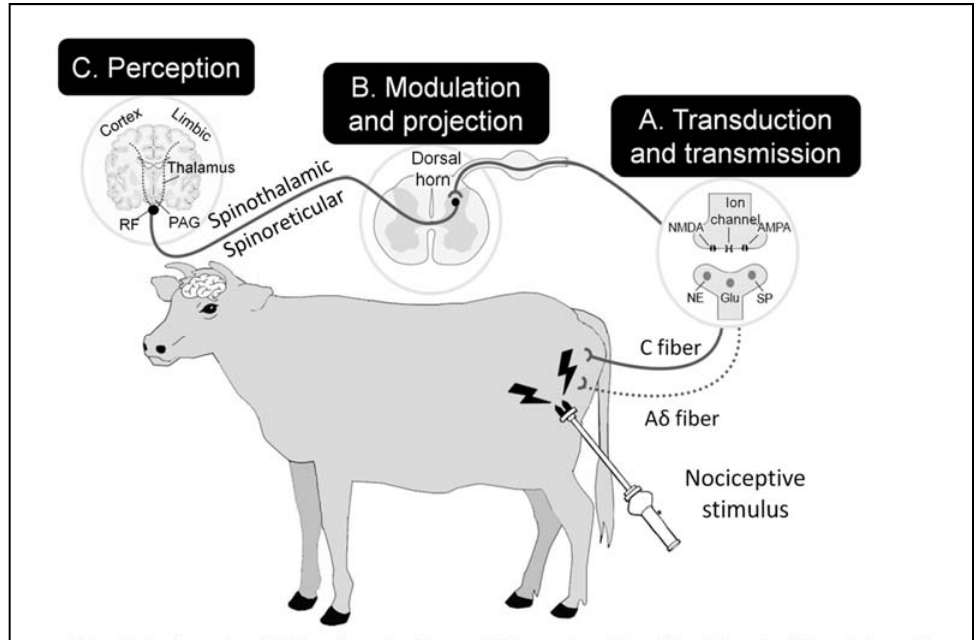
Figure 1. Schematic representation of nociceptor stimulation in response to a harmful stimulus produced by an electric drive. The first stage of transduction occurs when the harmful stimulus created by the electric drive activates nociceptors and is converted to an electrical impulse. The second stage is transmission, where the information is channelled through two primary efferent nociceptive neurons; the C-fibres (or C-polymodal nociceptors) and A-delta fibres [18]. Attenuation of the response occurs in the dorsal horn of the spinal cord and is called modulation. Finally, processing and integration of the response occurs so pain is perceived. N-Methyl-D-aspartate receptor (NMDA), and α -amino-3-hydroxy-5-methyl-4- isoxazolepropionic acid (AMPA).